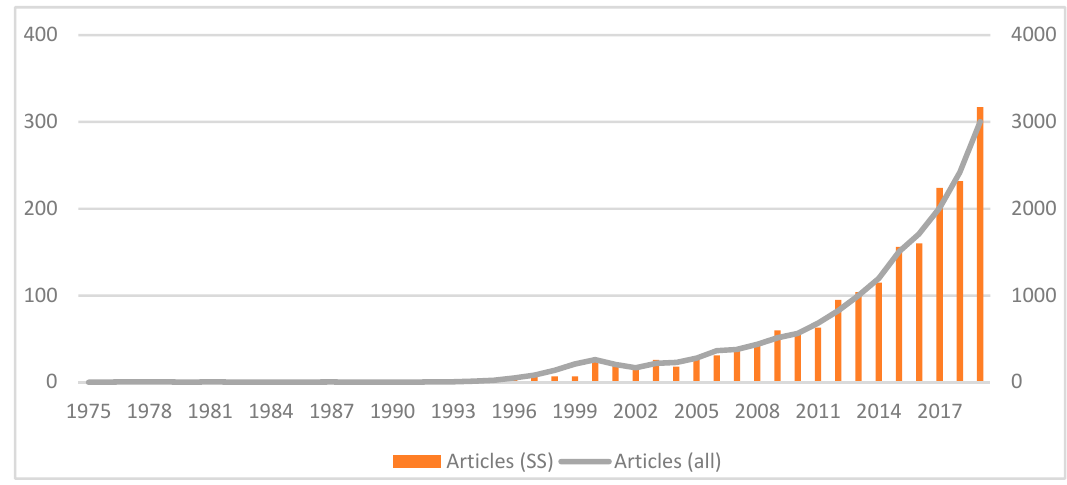
Figure 2. Evolution in the number of articles (Social Sciences (SS) and all areas).